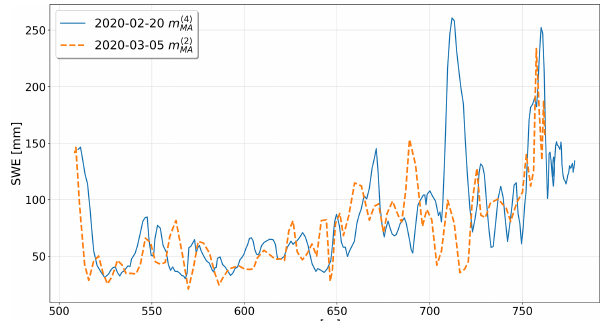
Figure 9. Retrieved SWE from same Magnaprobe section as shown in Fig. 5 on 20 February before a strong drifting snow event that occurred on 24–25 February and mass distribution on 5 March 2020 after the drifting snow event. The superscript numbers in brackets in the legend correspond to the count of numbers of the moving median window used for plotting.